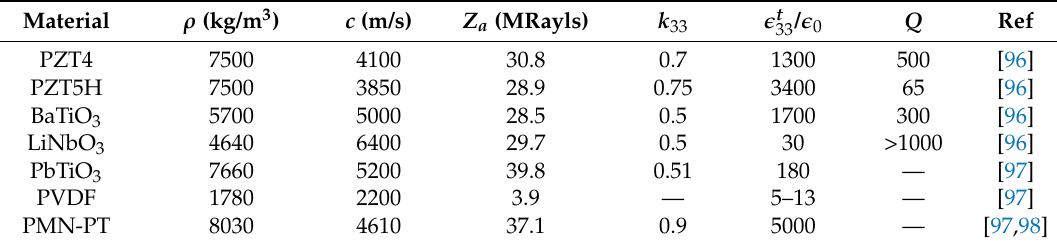
Table 1. Acoustic and electric material properties of commonly used piezoelectric materials. Density- ρ , sound velocity- c , acoustic impedance- Z a , electro-mechanical coupling- k 33 , quality factor- Q , and relative permittivity- (cid:101) t / (cid:101) 0 33